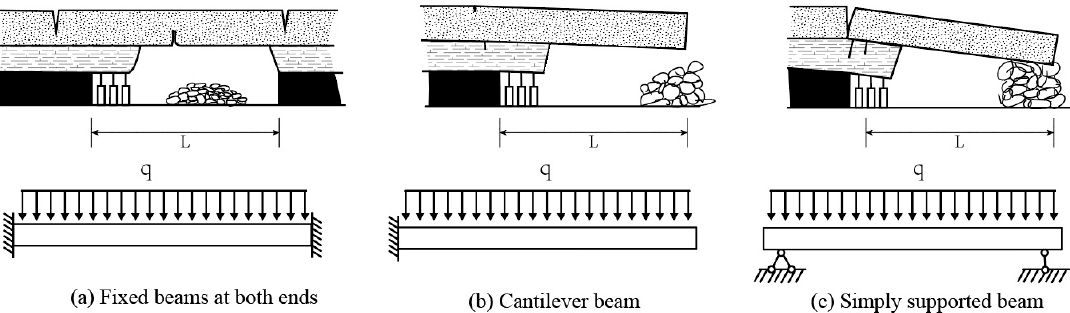
Figure 2. Three types of beams are formed in the suspended roof during coal mining.